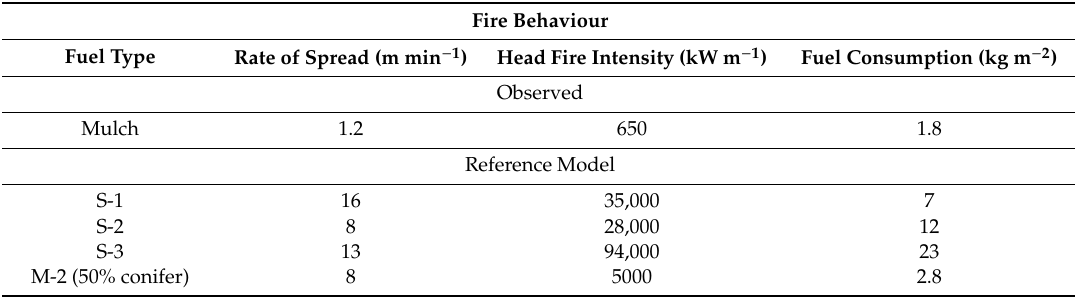
Table 3. Canadian Forest Fire Behaviour Prediction System values for observed mulch fire behavior and comparison fuel types S-1 Jack or Lodgepole Pine Slash, S-2 White Spruce / Balsam Slash, S-3 Coastal Cedar / Hemlock / Douglas-fir Slash, and M-2 Boreal Mixedwood Green (50%